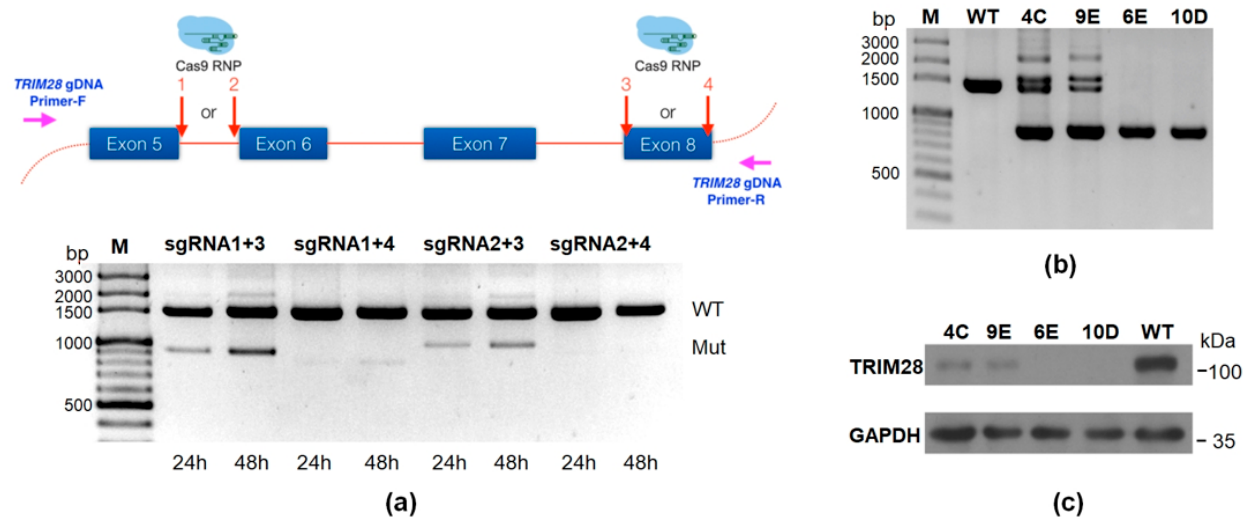
Figure 1. Knockout of TRIM28 in K562 cells. ( a ) Strategy of TRIM28 knockout in K562 cells. Two double-strand break sites on TRIM28 were generated at once using the nucleofection of a pair of Cas9-RNAs as indicated. After incubation for 24 h or 48 h, the editing efficiency was determined by PCR with TRIM28 gDNA primer set; the upper bands around 1500 bp (labeled as WT) are considered as having no editing, and the lower bands indicate a deletion of genomic DNA between the two editing sites. ( b ) The single cell was separated by an automatic cell sorter. Four clones (4C, 9E, 6E, and 10D) were isolated after genomic PCR. ( c ) TRIM28 protein expression analysis in these knockout clones.